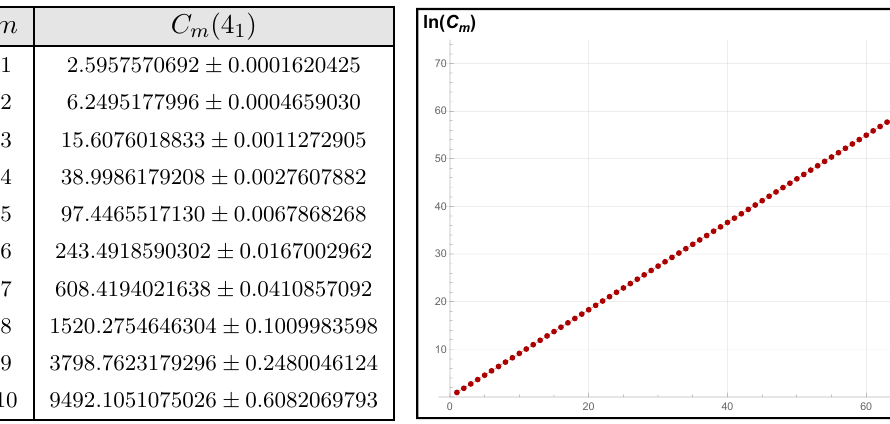
Figure 10. Variation of ln C m (4 1 ) with m